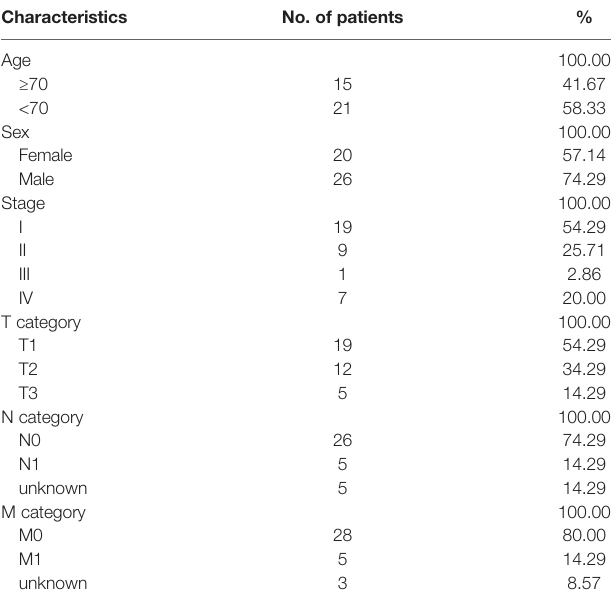
TABLE 1 | Characteristics of patients with cholangiocarcinoma from TCGA database.